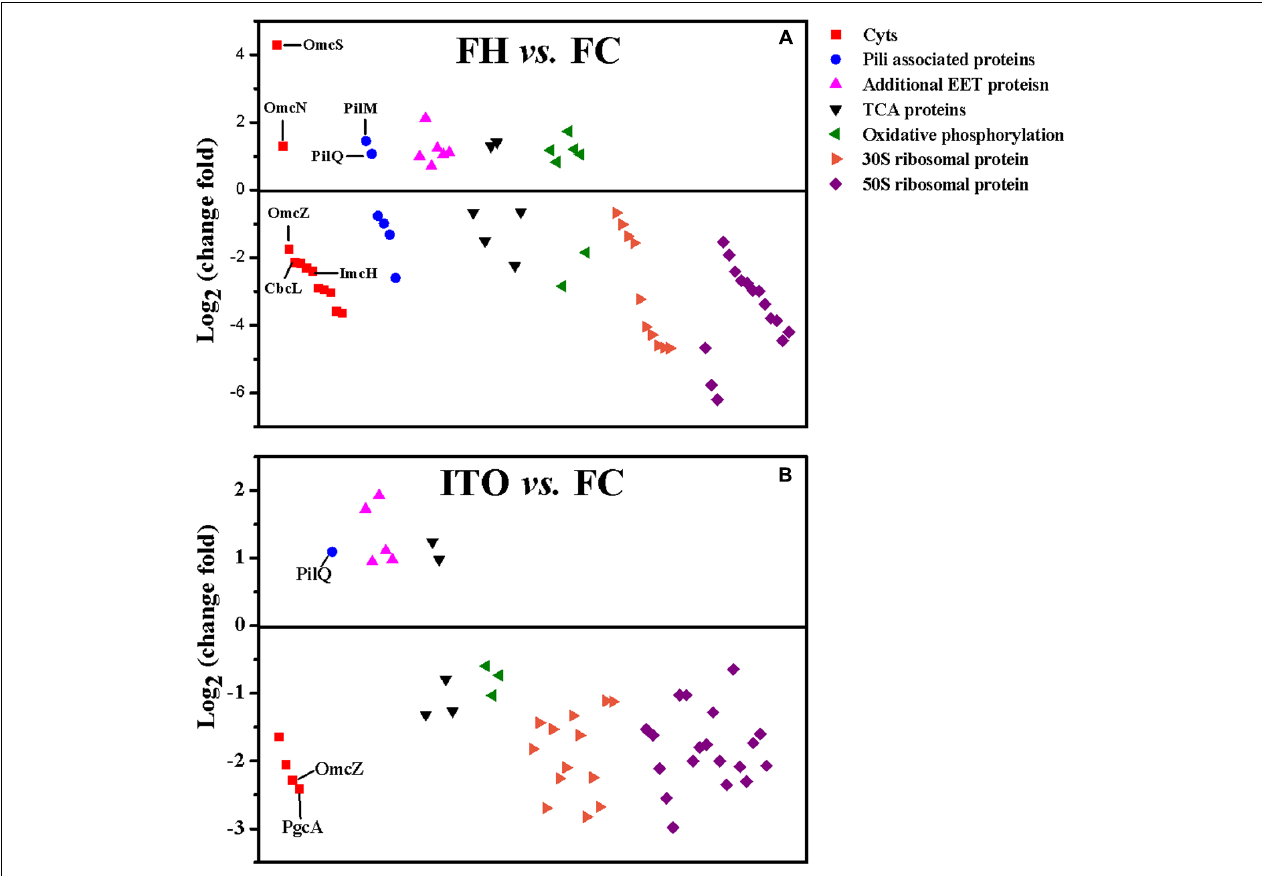
FIGURE 5 | Comparison of the expression of selected proteins that had significantly differential abundance in G. soli cells grown with FH (A) and ITO (B) compared with FC. The proteins in this figure are listed in Supplementary Table